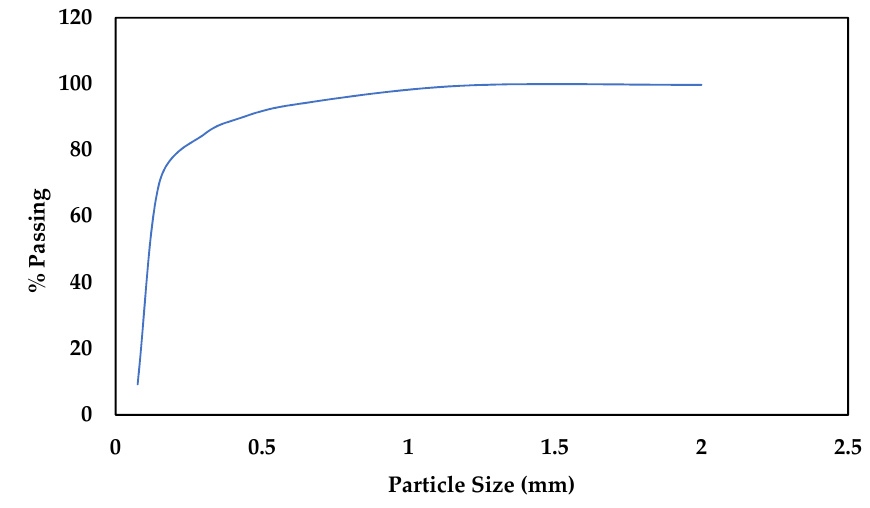
Figure 4. Average gradation of WFGD gypsum.